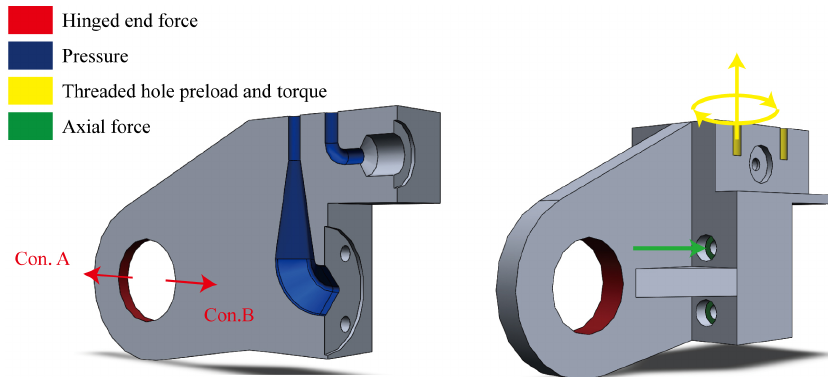
Figure 6. Schematic diagram of the force direction.